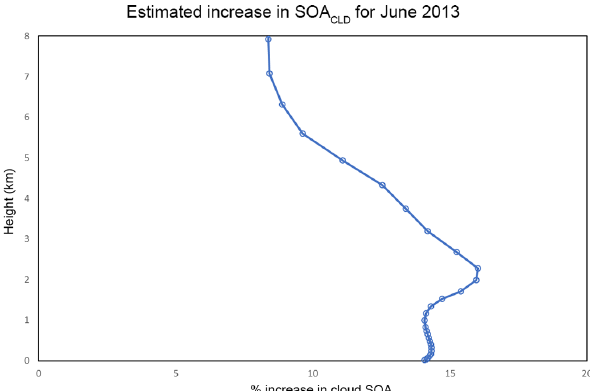
Figure 7. June 2013 average vertical distribution of the estimated percentage increase in cloud SOA with the addition of SOA from IEPOX/MPAN in cloud water. These values are averaged spatially over the area indicated by the blue box in Fig.